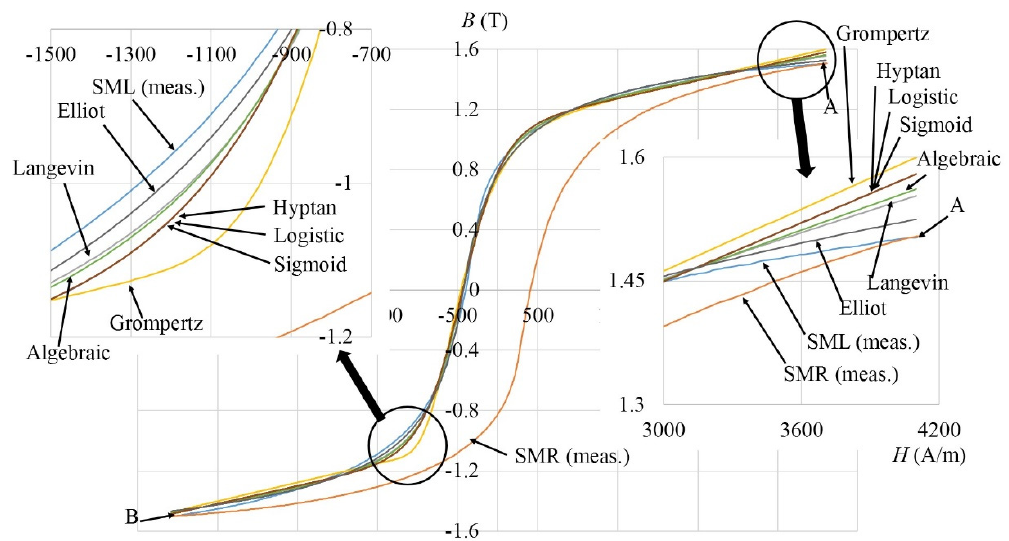
Figure 4. Graphically presented different expressions for SML.